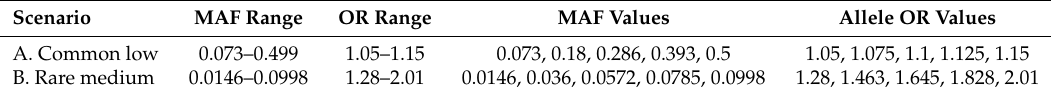
Table 5. Genetic architecture scenarios with modeled allele frequencies and effect